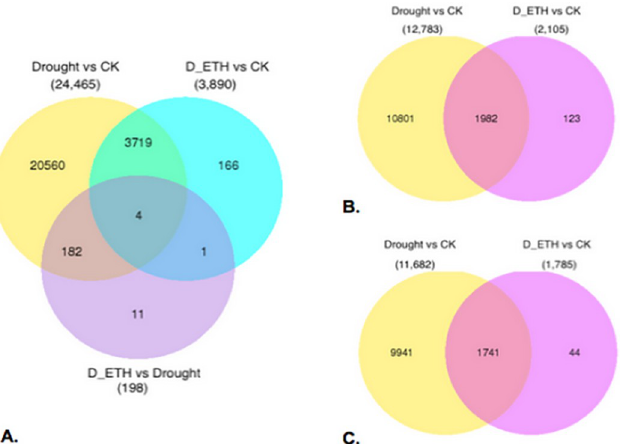
Fig 5. A. Venn diagram for all differentially expressed genes (DEGs) in Kentucky bluegrass B. Venn diagram for up- regulated genes in Kentucky bluegrass C. Venn diagram for down-regulated genes in Kentucky bluegrass. ‘CK’ means well-watered control plants without ethephon pre-treatment. ‘Drought’ means drought-stressed plants without ethephon application. ‘ETH_D’ means drought stressed plants with ethephon pre-treatment. DEGs were quantified at false discovery rate threshold (FDR) of 0.001 and log2 (fold change) larger than 2. Total DEGs for each comparison are shown in